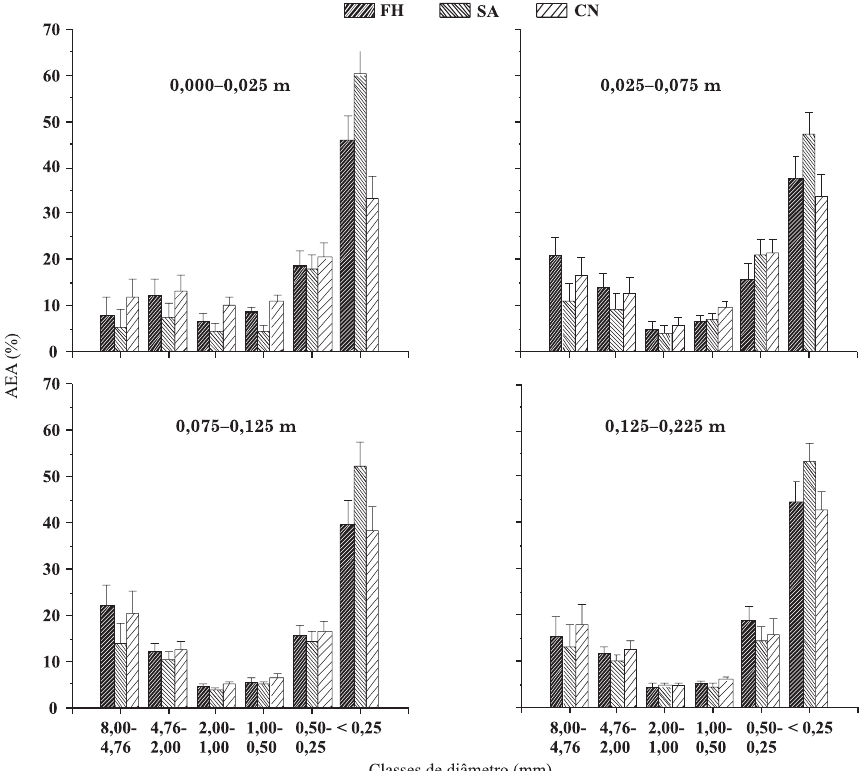
Figura 1. Agregados estáveis em água (AEA) em diferentes classes de um Argissolo Vermelho submetido a diferentes sistemas de uso e camadas. Barras verticais indicam a diferença mínima significativa a 5 % entre sistemas de uso em cada classe de